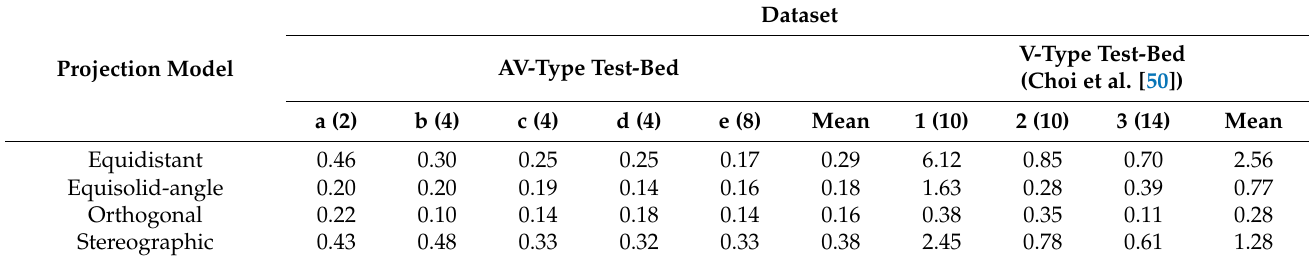
Table 18. Comparison of RMS-residuals of IOPs